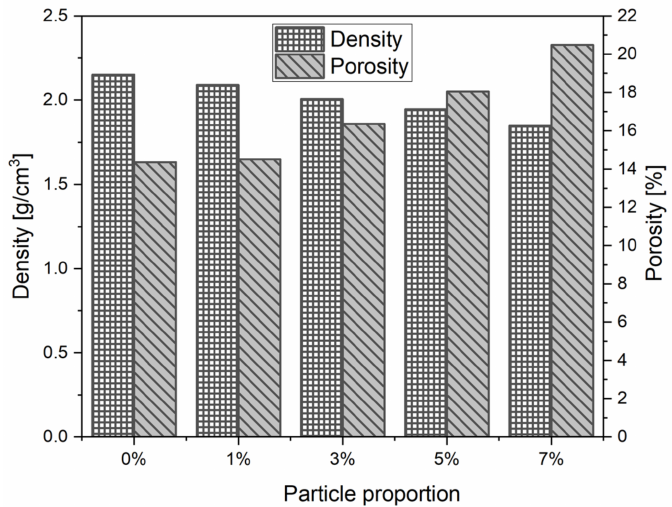
Figure 10. Density and porosity of alkali-treated